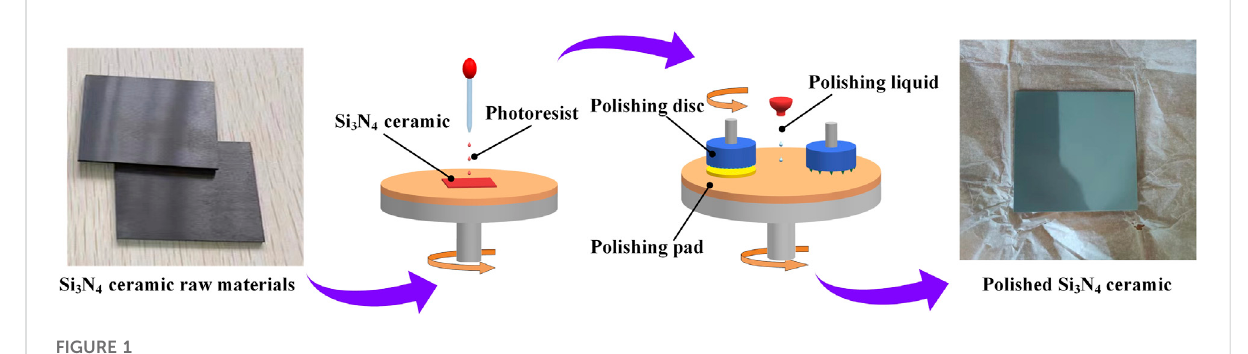
FIGURE 1 Polishing process of Si 3 N 4